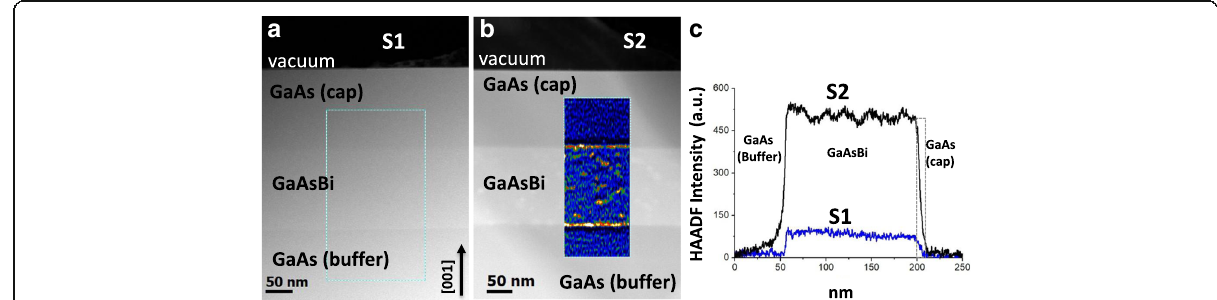
Fig. 1 a Cross-sectional HAADF-STEM images of sample S1 showing GaAs/GaAsBi/GaAs interfaces. b Cross-sectional HAADF-STEM image of sample S2, in the GaAsBi layer bright spots distributed along the GaAsBi layer related to Bi-rich areas are observed. Detail using temperature colour scale of an area after applying a low-pass filter is included as an inset in the same image for a better visualisation. c Thickness gradient-corrected intensity profiles taken along [001] direction from the regions marked with green rectangles in the HAADF-STEM images, blue line for sample S1 and black line for sample S2, showing a slightly different behaviour at the